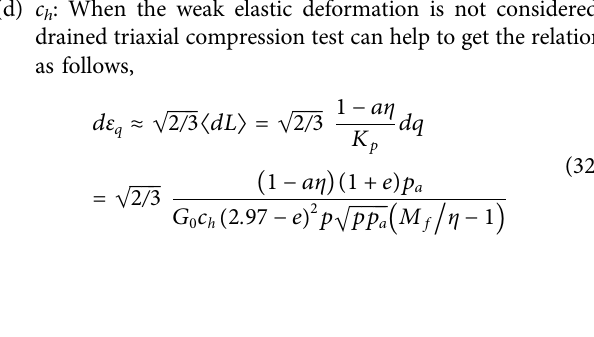
Frontiers in Earth Science |